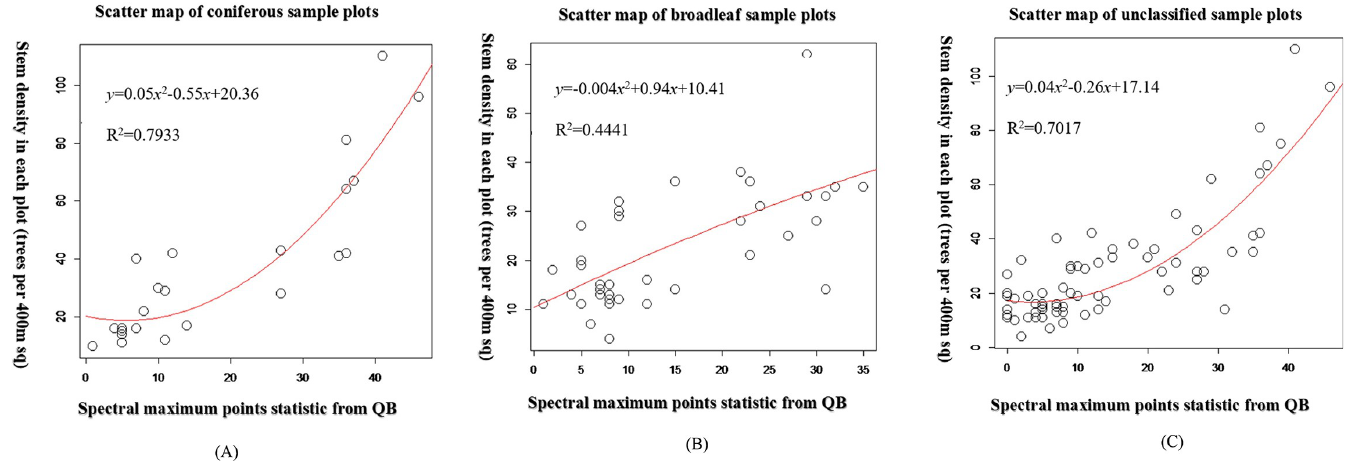
Fig 6. Number of trees / 400 square meters–observations of stand density against number of spectral local maximum points. Note: (A) Represents the scatter plot of stand density in coniferous sample plots. (B) Represents the scatter plot of stand density in broadleaf sample plots. (C) Represents the scatter plot of stand density in all stand sample